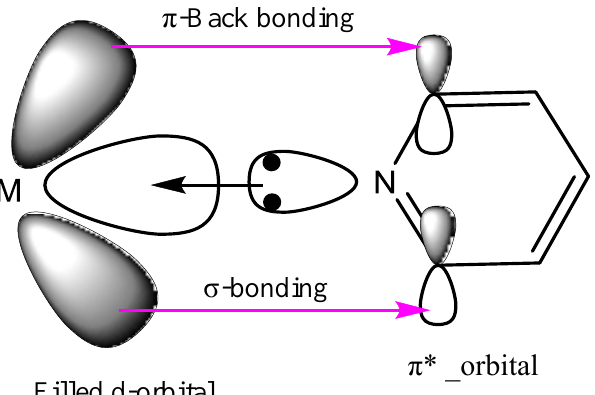
Figure 4. Illustration of general σ -bonding and π -back bonding between a transition metal and a pyridine moiety of asphaltenes. This strongly suggests that, on the nanoparticle support, asphaltenes are adsorbed sideways and normal or at an angle to the surface. Taken from Pal et al. [47].